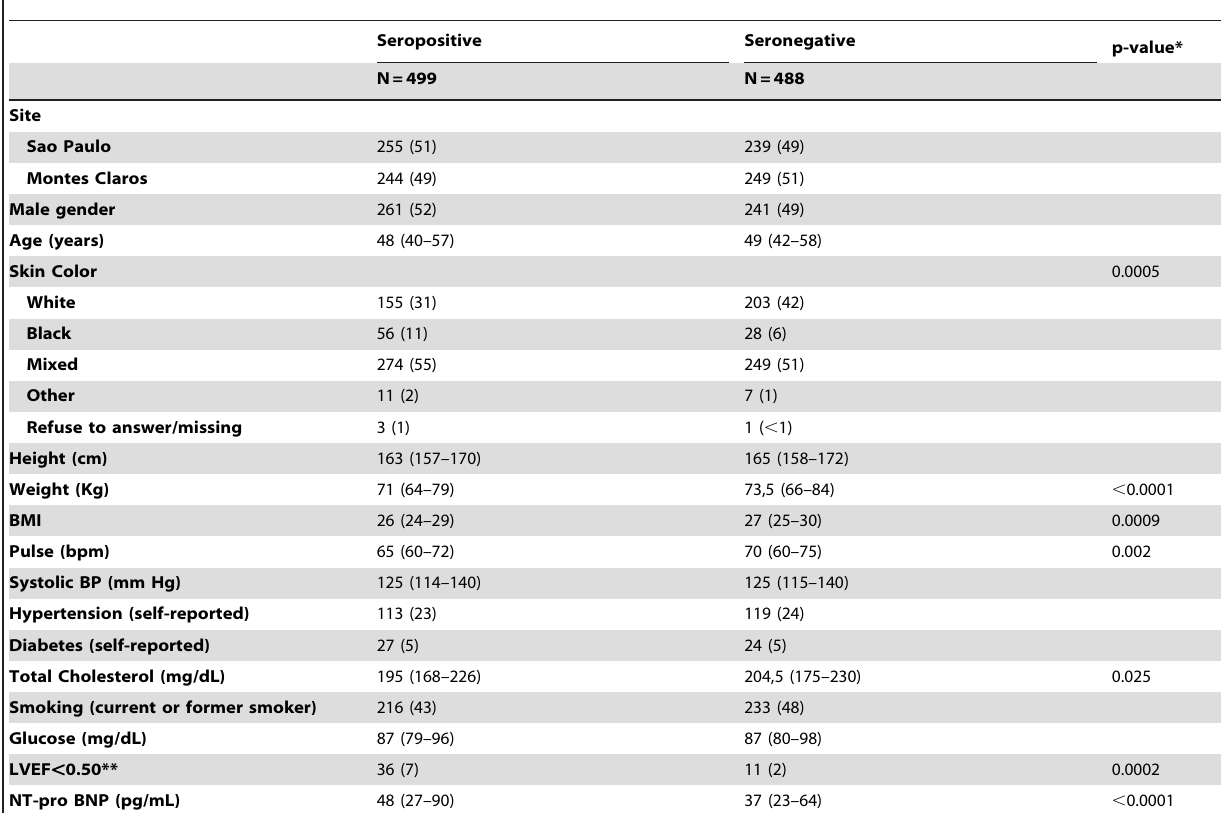
Table 1. Demographic and medical characteristics of the study population, by T.cruzi antibody status.